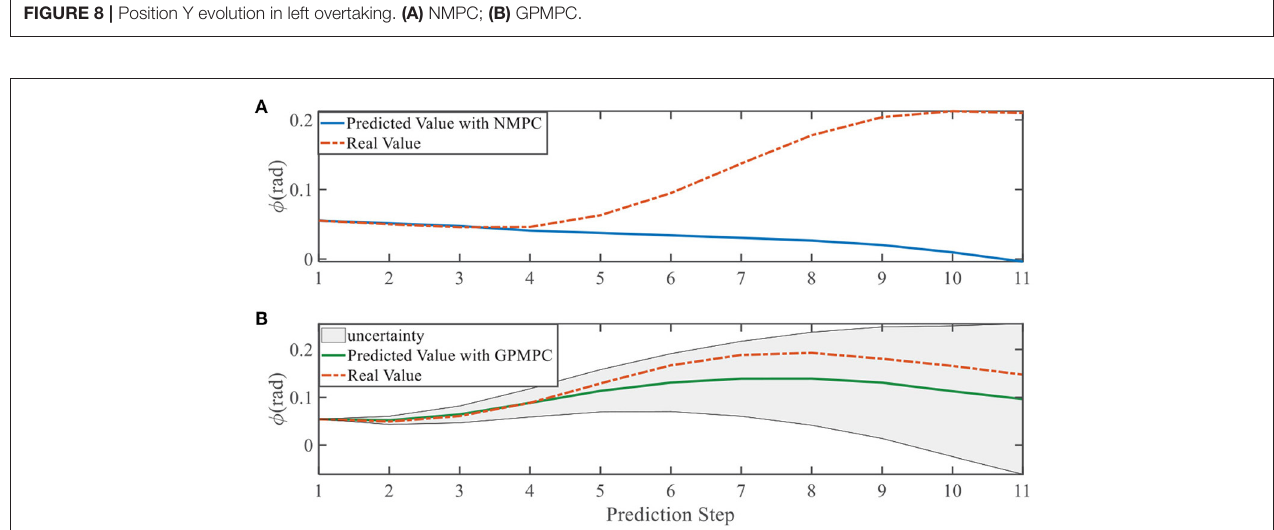
FIGURE 9 | Yaw angle evolution in left overtaking. (A) NMPC; (B) GPMPC.